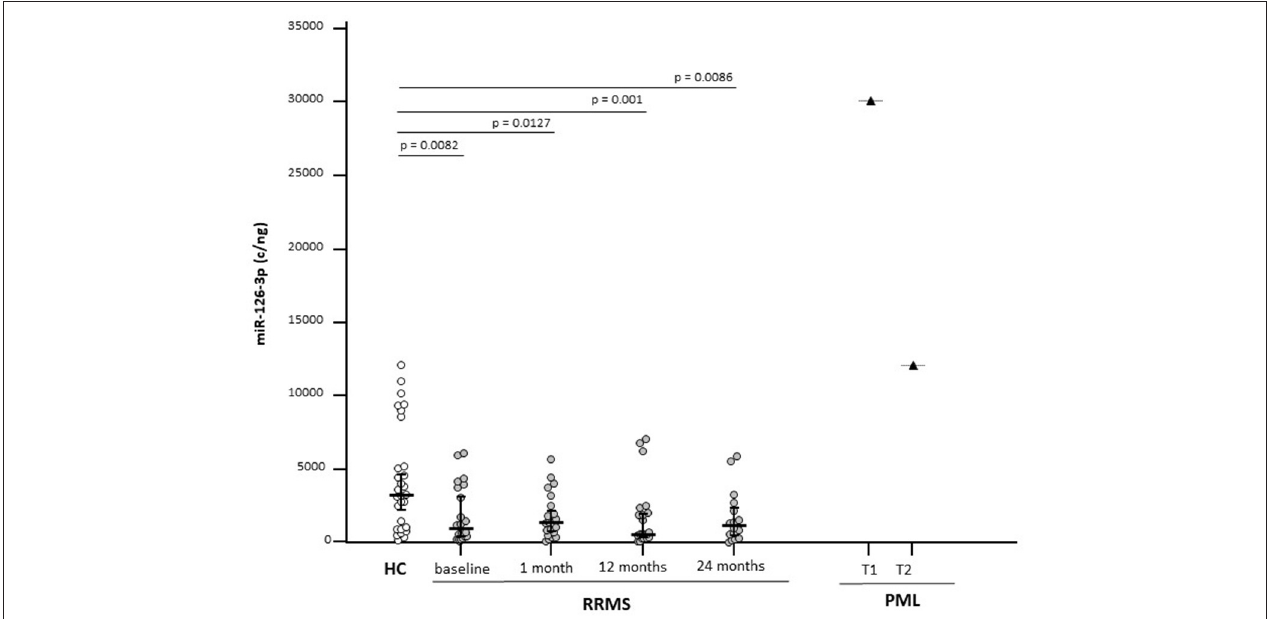
FIGURE 1 | Serum microRNA-126-3p (miR-126-3p) concentrations in patients with a diagnosis of relapsing-remitting multiple sclerosis (RRMS) ( N = 22) or progressive multifocal leukoencephalopathy (PML) ( N = 1) and in age-and sex-matched healthy controls (HCs) ( N = 29). Results before (baseline) and at 3 different time points are initiation of natalizumab (NTZ) therapy are shown. For the patients with PML, time at PML diagnosis (T1) and 12 months after PML diagnosis (T2) are shown. miR-126-3p expression (copies/ng) is presented as median and interquartile range (IQR). Statistical significances are